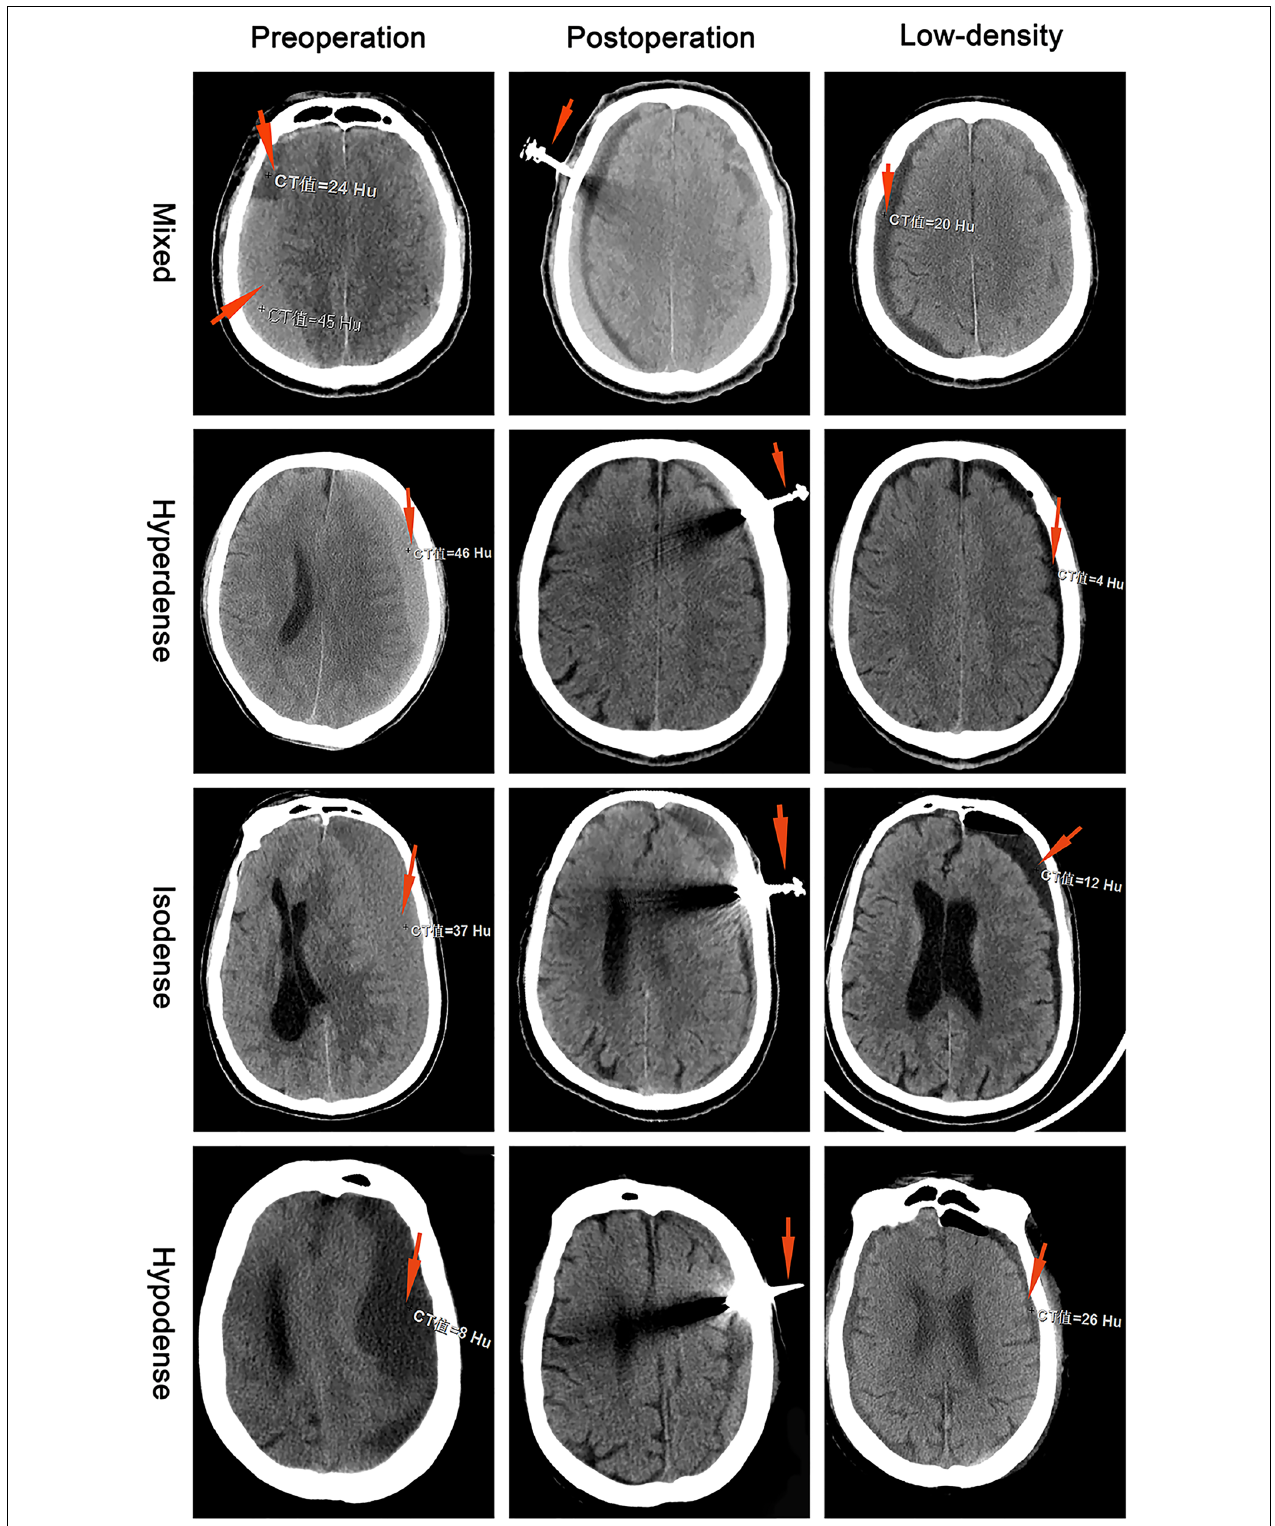
FIGURE 3 | Chronic subdural hematoma classification: mixed, hyperdense, isodense, and hypodense. The preoperative red arrows show the CT values (Hu) for different CSDH types. The postoperative red arrow shows the YL-1 drainage tube. The low-density red arrow shows that the CT value (Hu) of the CSDH was less than